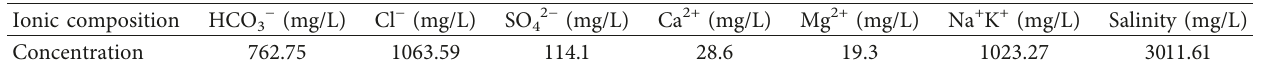
Table 2: Ionic content of simulated formation water from Block Qizhong, Xinjiang.